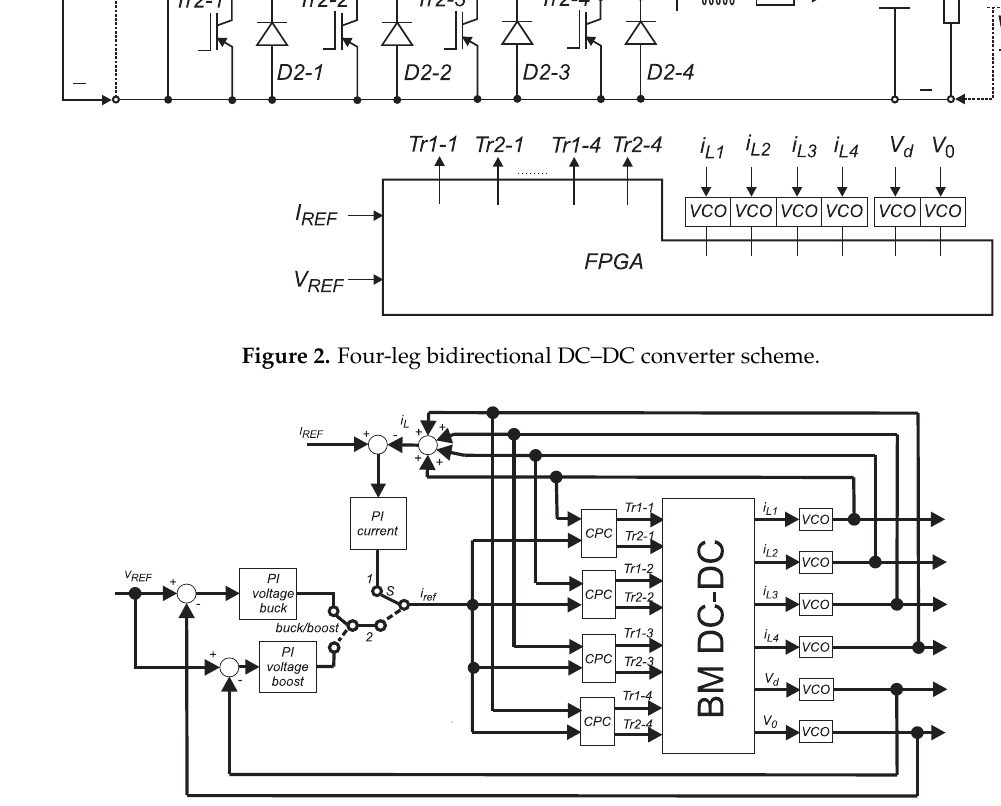
Figure 3. Control